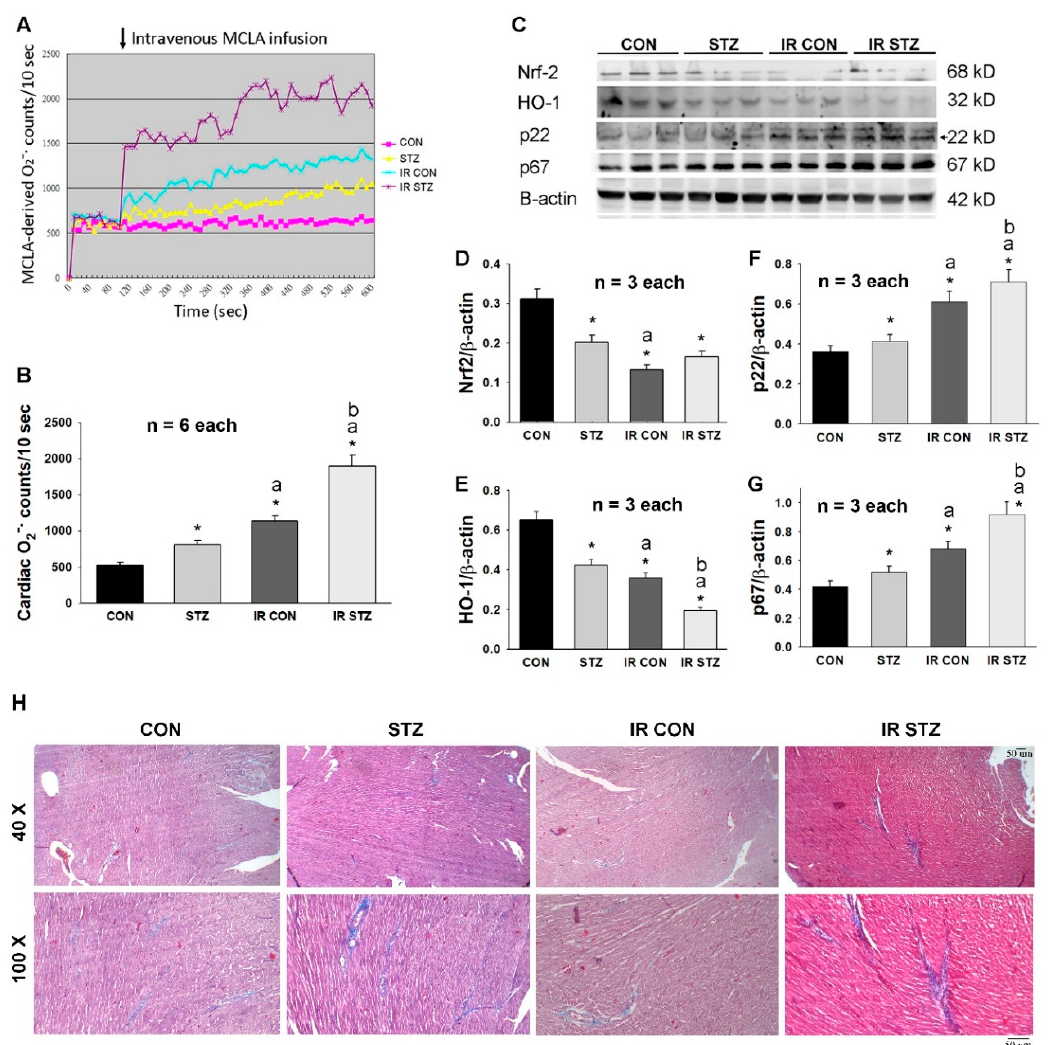
Figure 4. The diabetes effect on IR affected cardiac O 2 − amount ( A , B , n = 6), antioxidant defense mechanism, Nrf-2 and HO-1 expression ( C , D , E , n = 3) and NADPH oxidase p22 and p67 expression ( C , F , G , n = 3) using the single values in four groups of rats. Data are expressed as mean ± SEM. The Masson’s trichrome stain (yellow head) for cardiac fibrosis is indicated in H . * p < 0.05 vs. CON, a p < 0.05 vs. STZ, b p < 0.05 vs. IR CON.